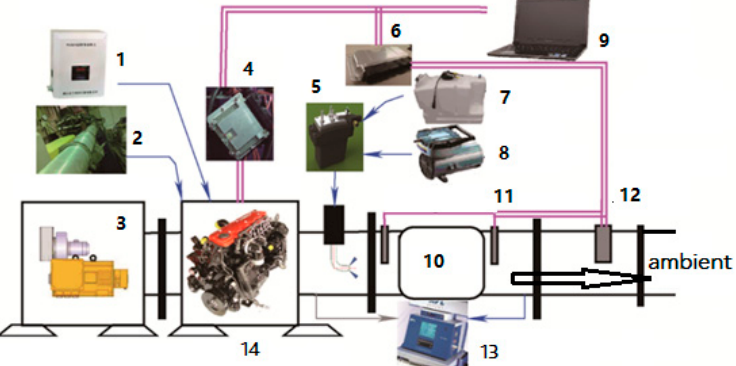
of the UWS control method performance. The engine experiment platform is shown in Figure 4.